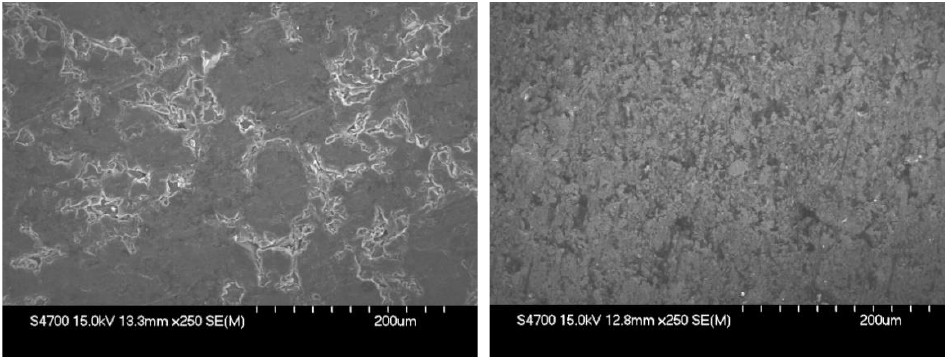
Figure 6. SEM images of the surface of Eisenhuth Melange 6 ( left ) and MEGA Extrusion ( right